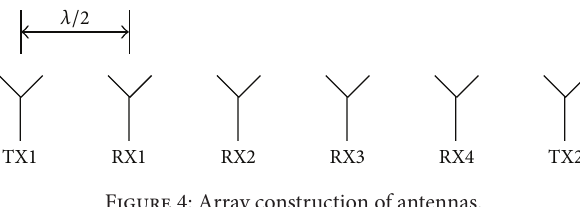
Figure 4: Array construction of antennas.